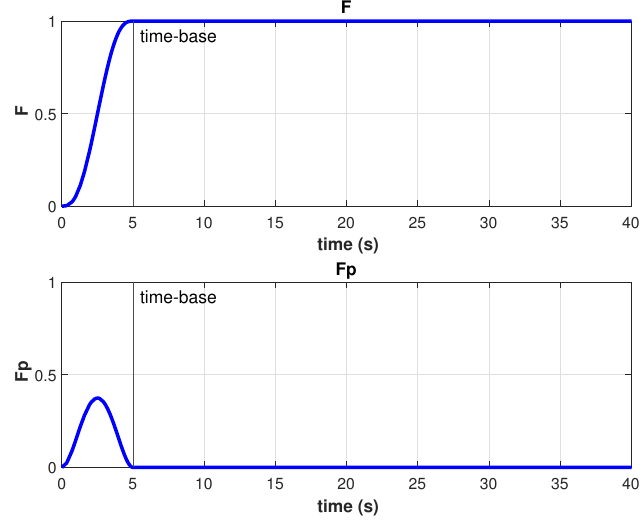
Figure 13. Time base generator results for t b = 5 s.